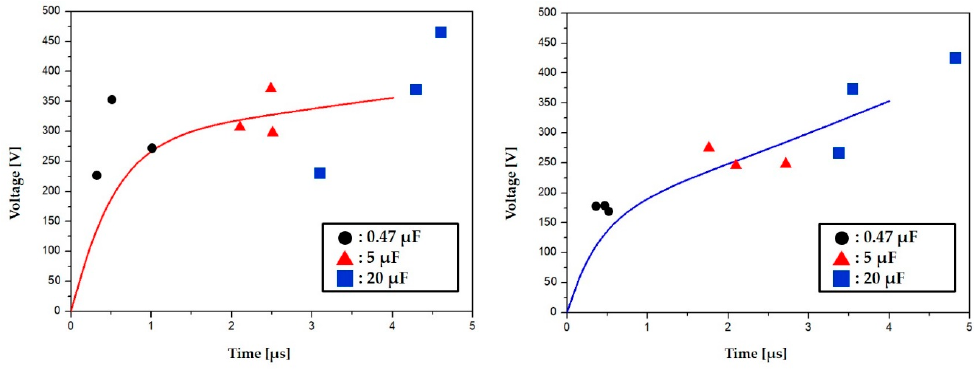
Figure 8. Experiment waveform (according to plate structure).